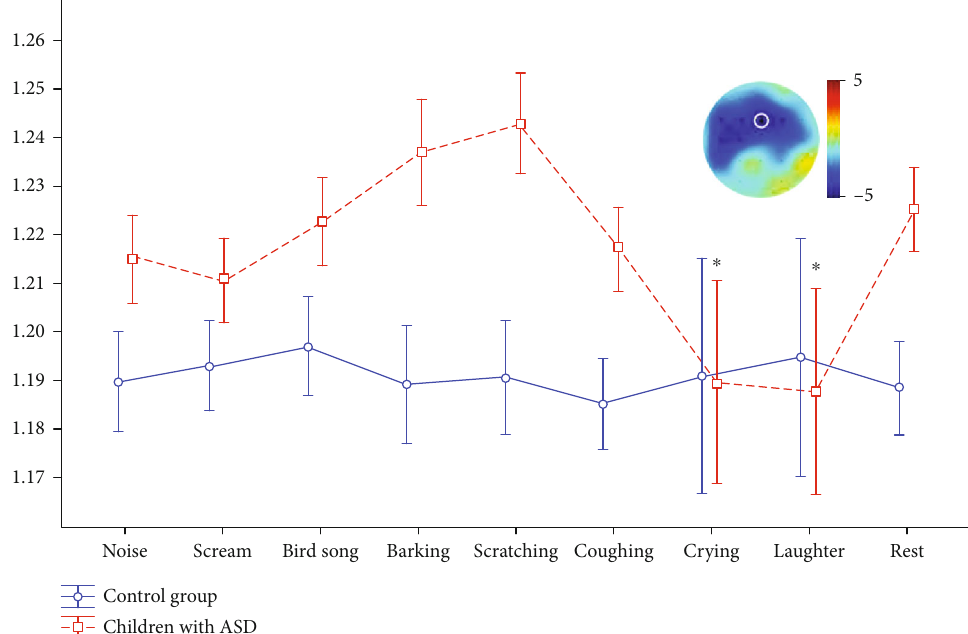
Figure 3: The dynamic of FD when listening to stimuli and rest. x (abscissa): the types of stimuli presented to participants; y (ordinate): FD averaged for participants of each group. ∗ Signi fi cant di ff erences between stimuli and rest with topography of these di ff erences (averaged for crying and laughter) in children with ASD. White circle: Fz — electrode in which FD values were